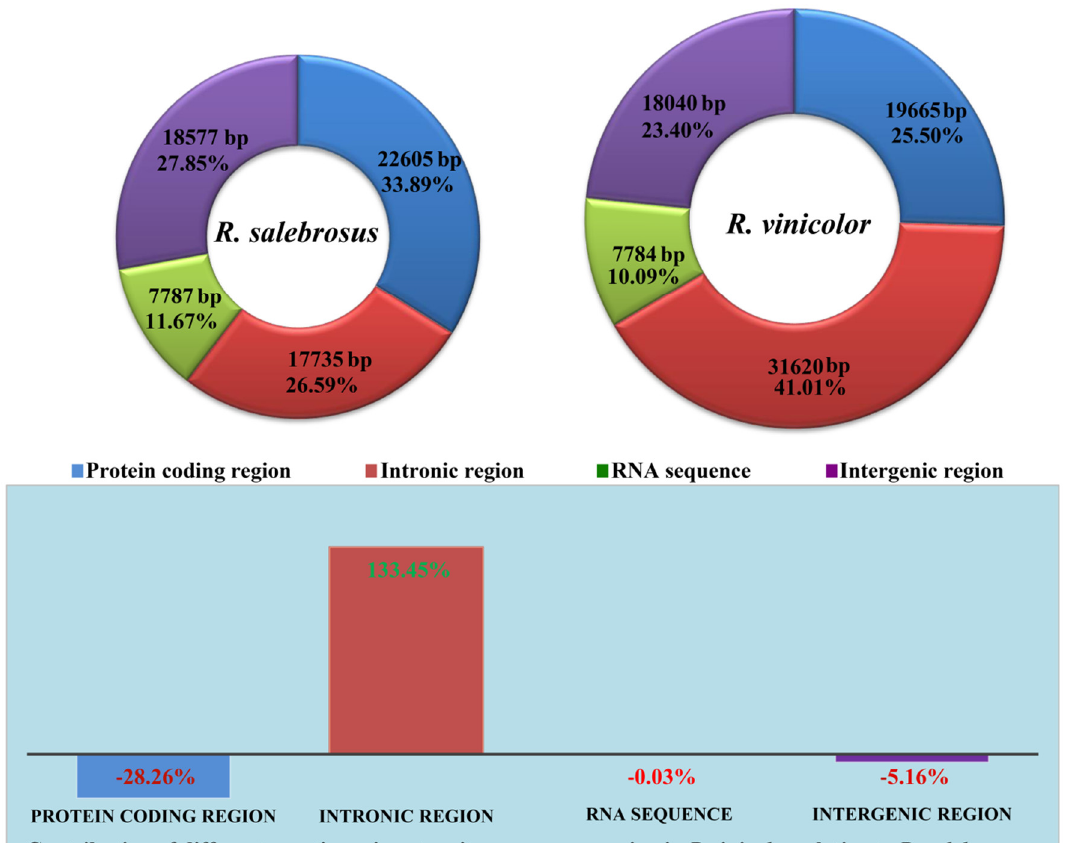
Figure 3. The protein-coding, intronic, intergenic, and RNA gene region proportions of the entire mitogenomes of the two Rhizopogon species. The bottom panel shows the contribution of different gene regions to the expansion of the R. vinicolor mitogenome.